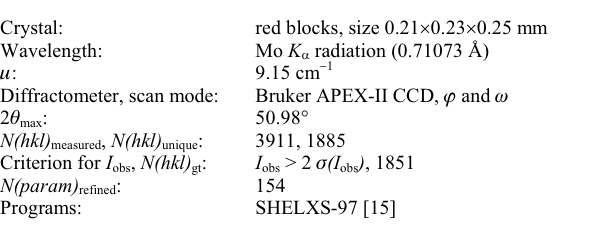
Table 1. Data collection and